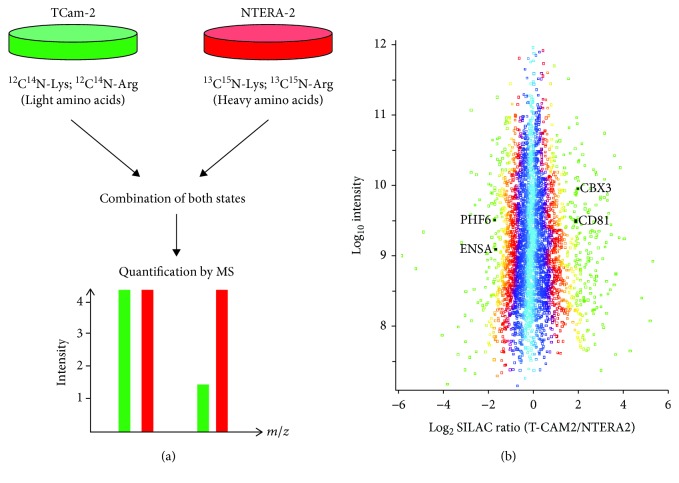
Proteomic profiling of testicular germ cell cancer cell lines. Workflow of SILAC-based mass spectrometry experiments. TCam-2 and NTERA-2 were metabolically labeled with amino acids of different masses allowing a comprehensive relative quantification of protein expression by mass spectrometry (a). Distribution of SILAC ratios of all quantified proteins according to their relative expression in NTERA-2 and TCam-2 (b).